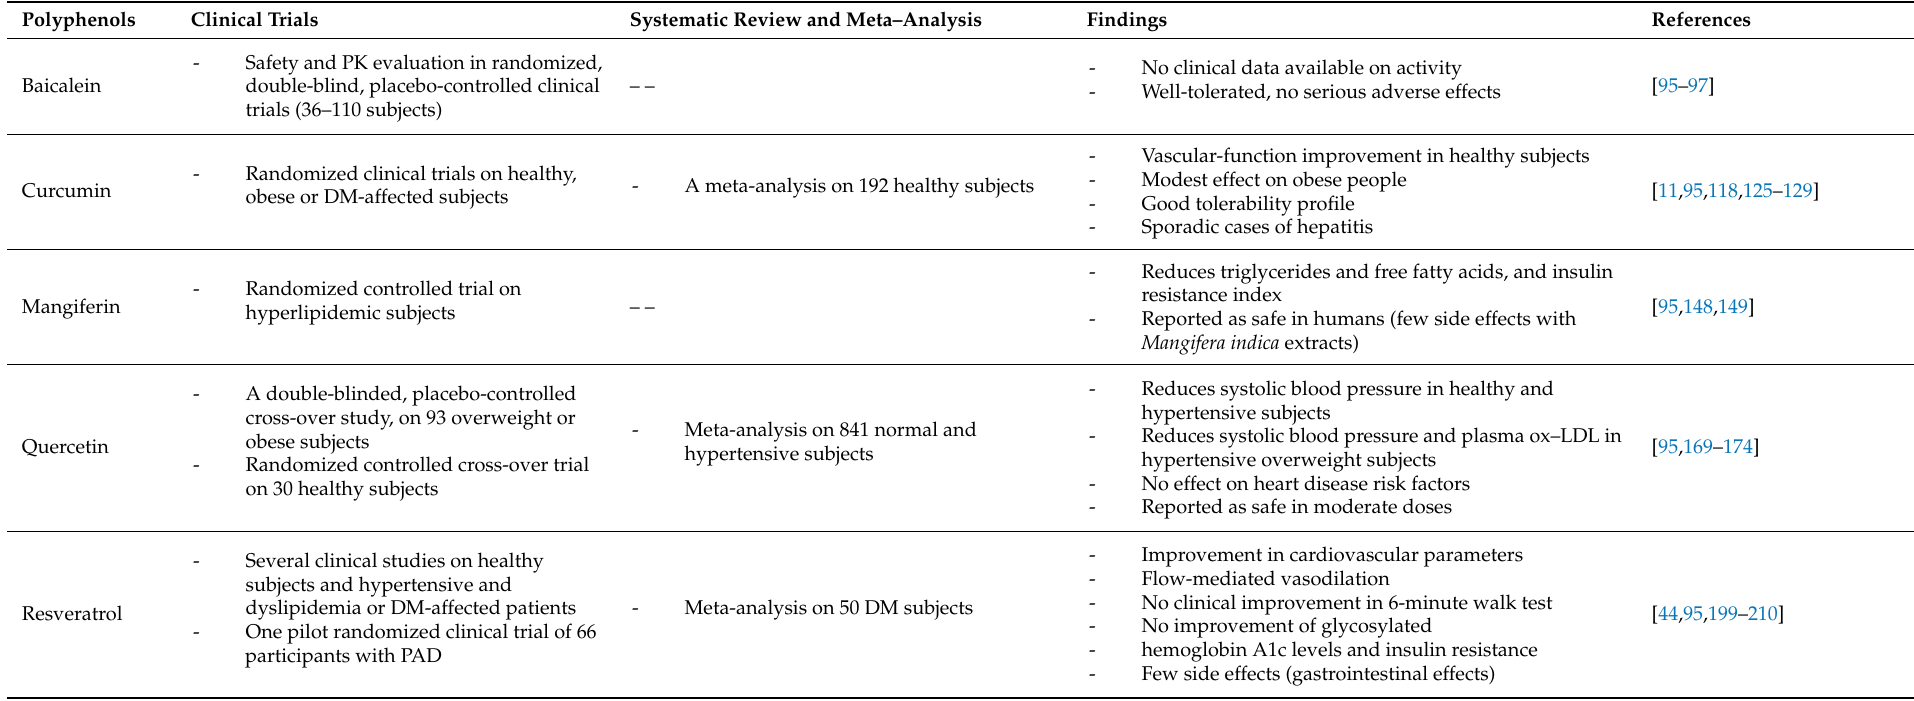
Table 2. Plant-derived polyphenols with potential activity in preventing cardiovascular diseases and, thus, also PAD: clinical trials and adverse reactions.